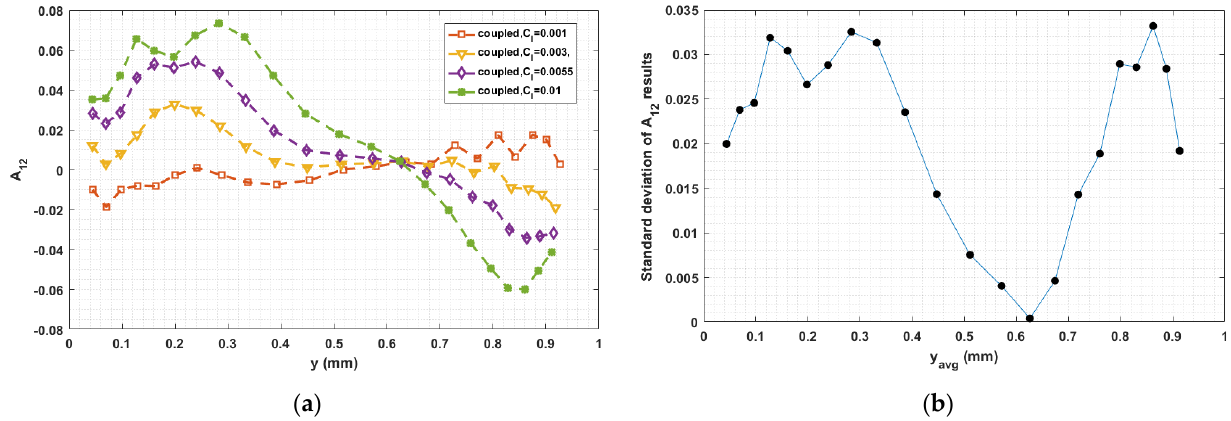
Figure 22. ( a ) Fiber orientation tensor component A 11 at flow end; ( b ) standard deviation of the parametric study resulted A 11 versus the averaged y locations.